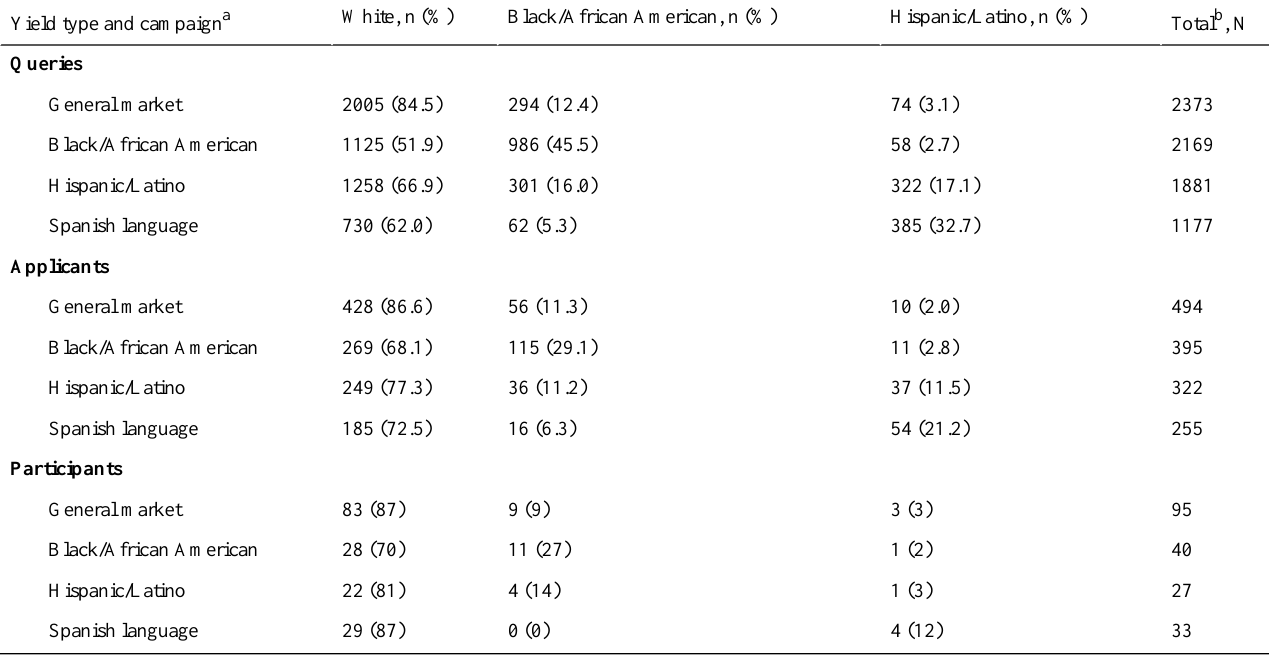
Table 1. Estimated campaign yields based on spending US $20/day on each campaign for 2